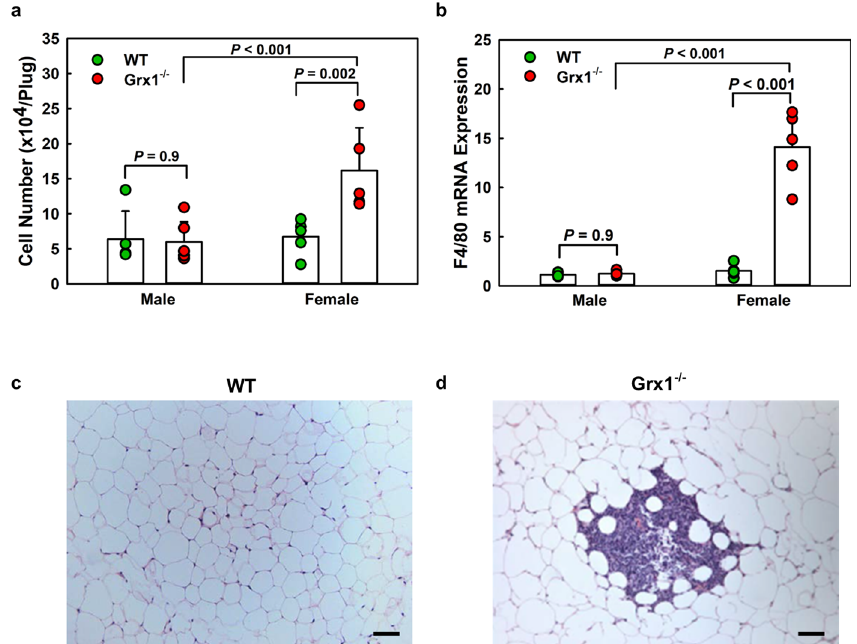
Fig. 2 Assessment of monocyte chemotactic activity in vivo and macrophage recruitment into gonadal adipose tissues from aged male and female mice. a Recruitment monocyte-derived macrophages into implanted Matrigel plugs loaded with. CP-1. b F4/80 mRNA expression in gonadal adipose tissues. c , d Representative images of gonadal adipose tissue section stained with H&E. Scale bar = 50 μ m All data are expressed as mean ± S.D., n = 5 – 6 mice per group for a and b . One-way ANOVA followed by Fisher ’ s Least Signi fi cance Difference test was used to compare the mean values between experimental groups. * P < 0.05; ** P < 0.01; *** P < 0.001. Source data are provided as a Source Data fi